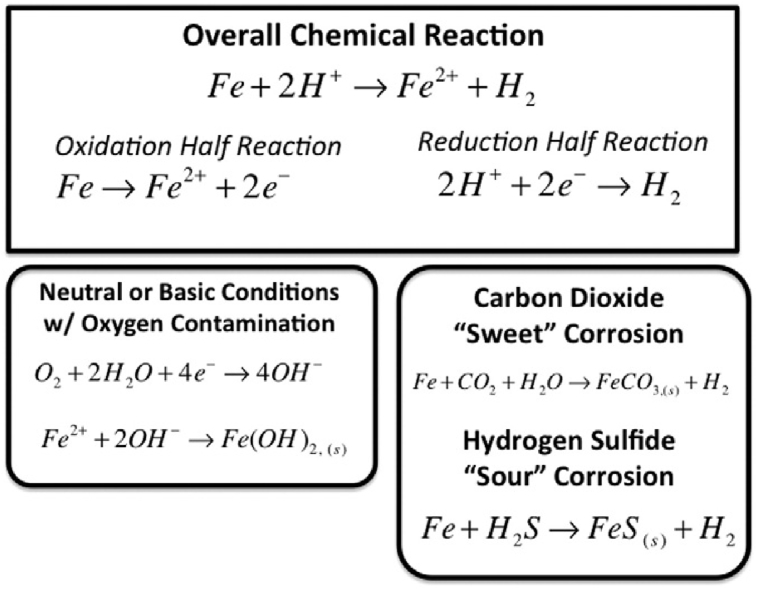
Chemical reactions of corrosion process [16].